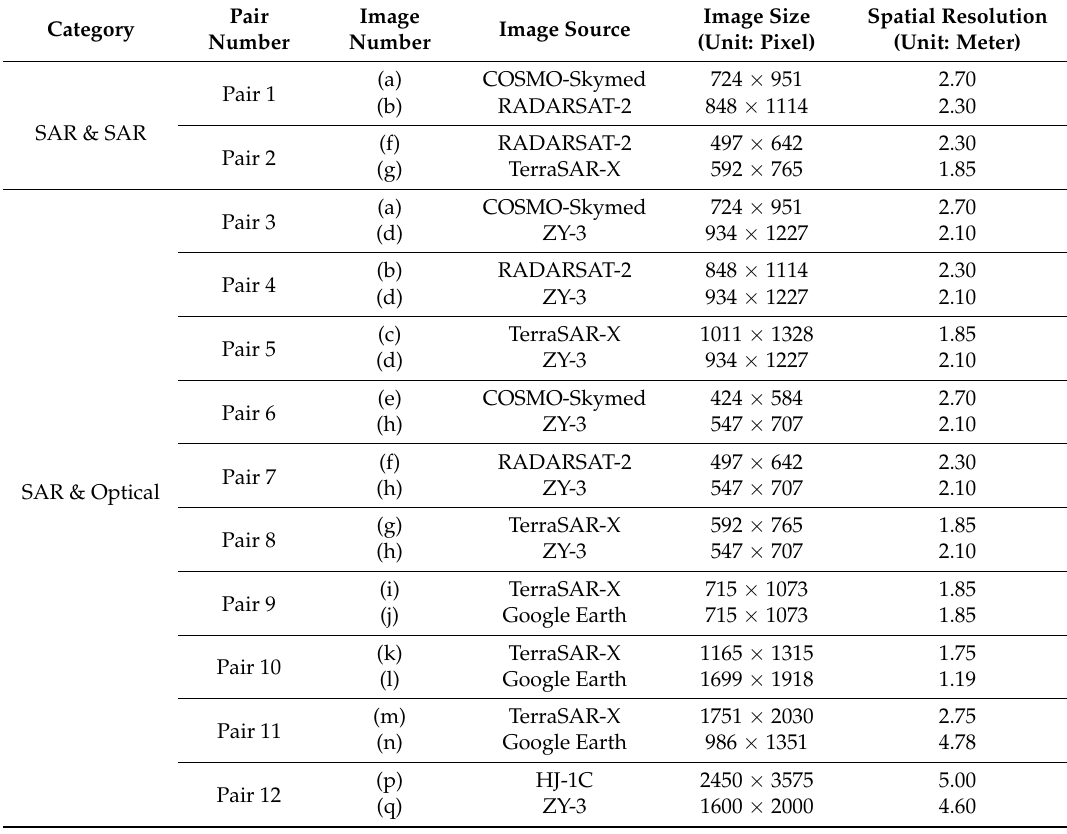
Table 2. Description of image pairs used in the experiments.